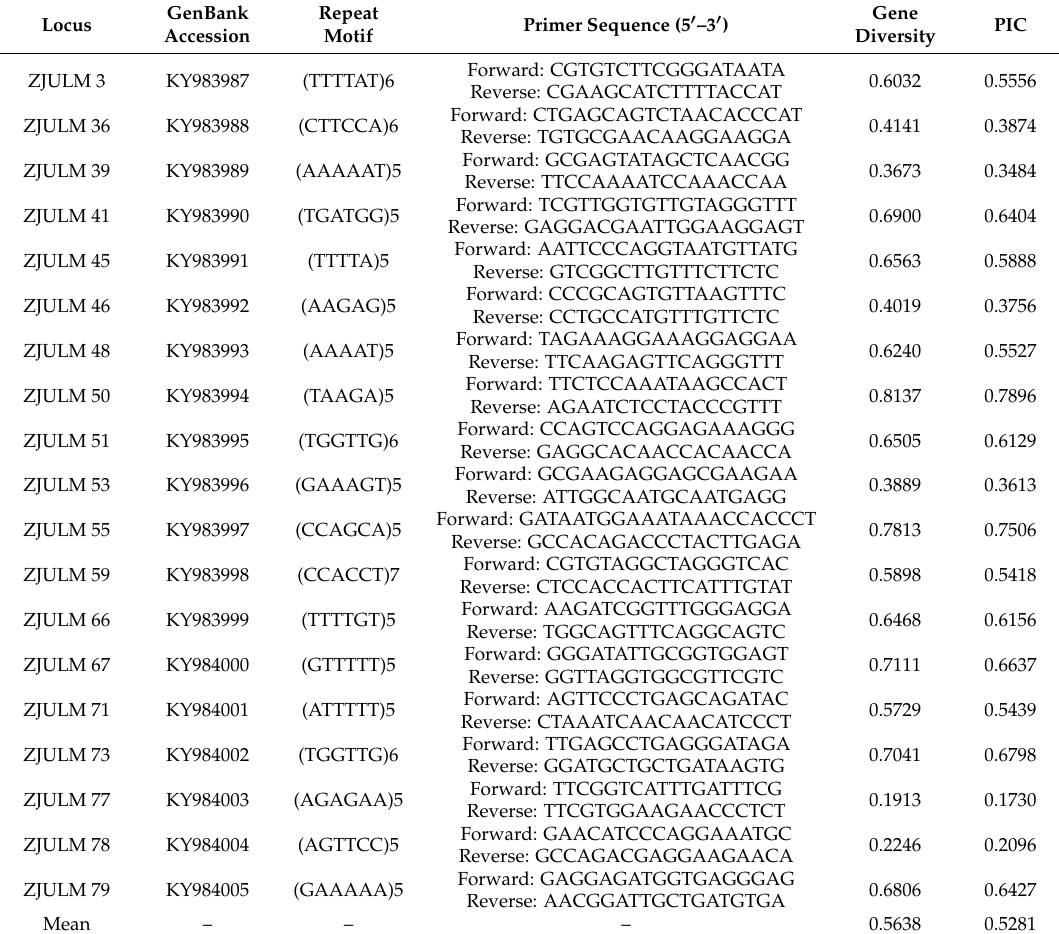
Table 4. Characteristics of 19 SSR markers in present